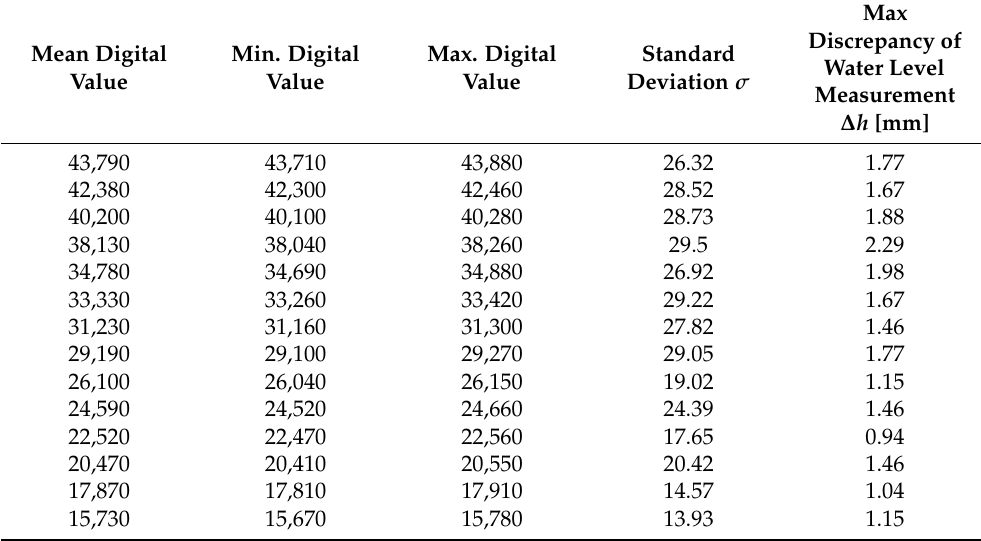
Table 3. Statistical analysis of wave measurement